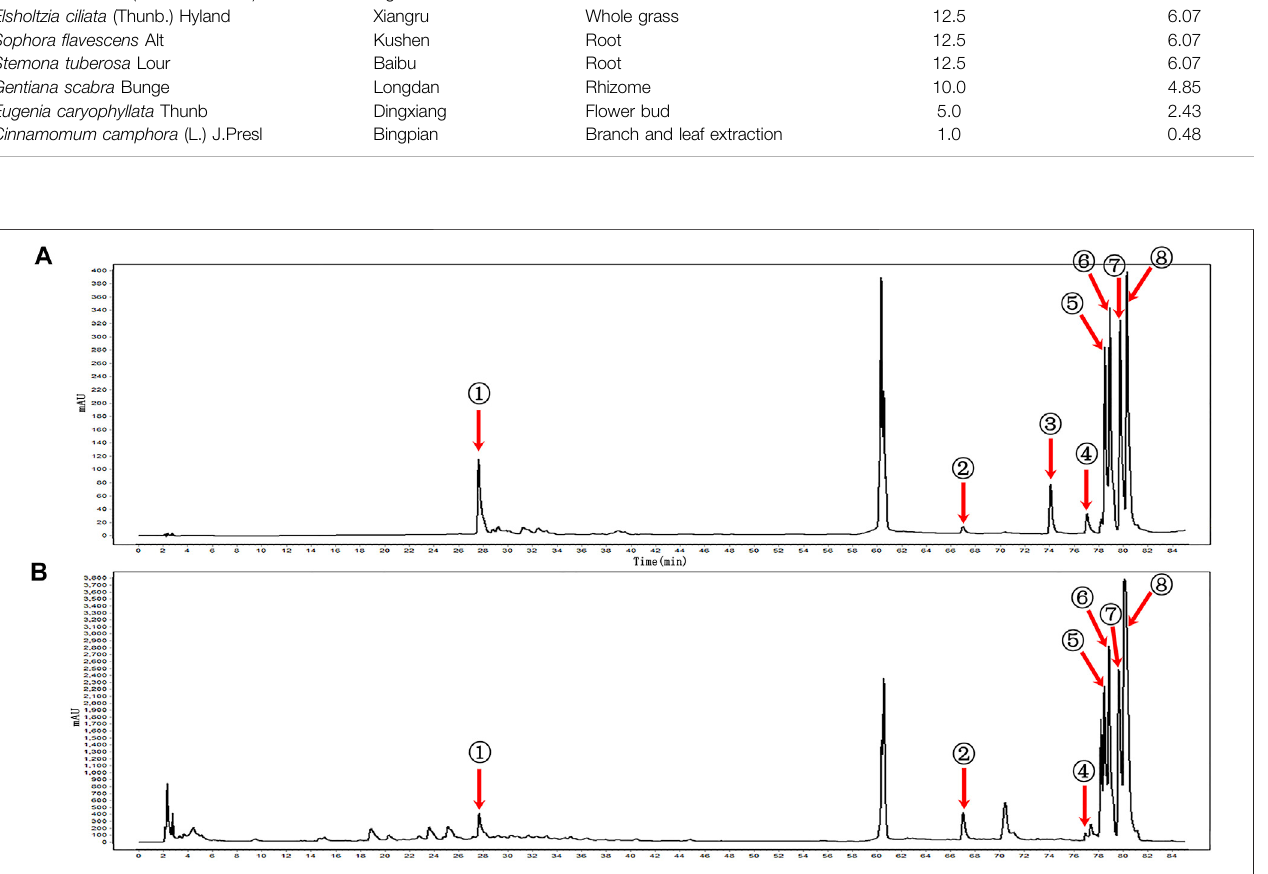
Frontiers in Pharmacology |